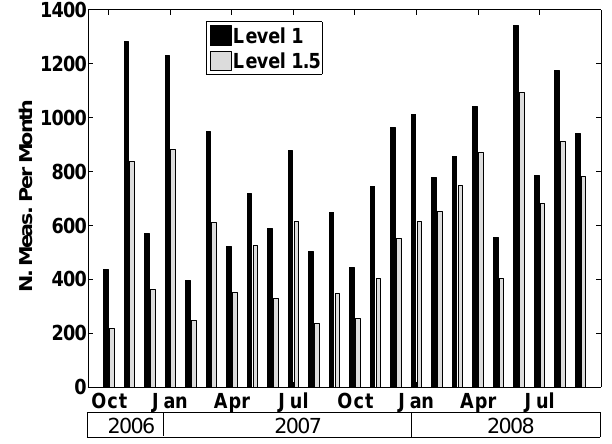
Fig. 1. Number of AOD measurements per month at the IASBS site, October 2006 to September 2008, level 1.0 (raw data) and 1.5 (cloud free